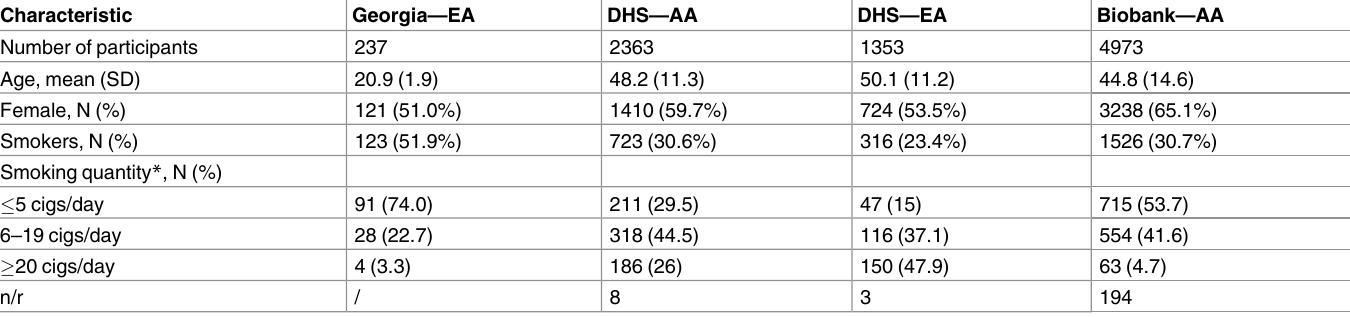
Table 1. Characteristics of the study participants in the three different cohorts. DHS, Dallas Heart Study; AA, African-Americans; EA, European- Americans. Characteristic Georgia—EA DHS—AA DHS—EA